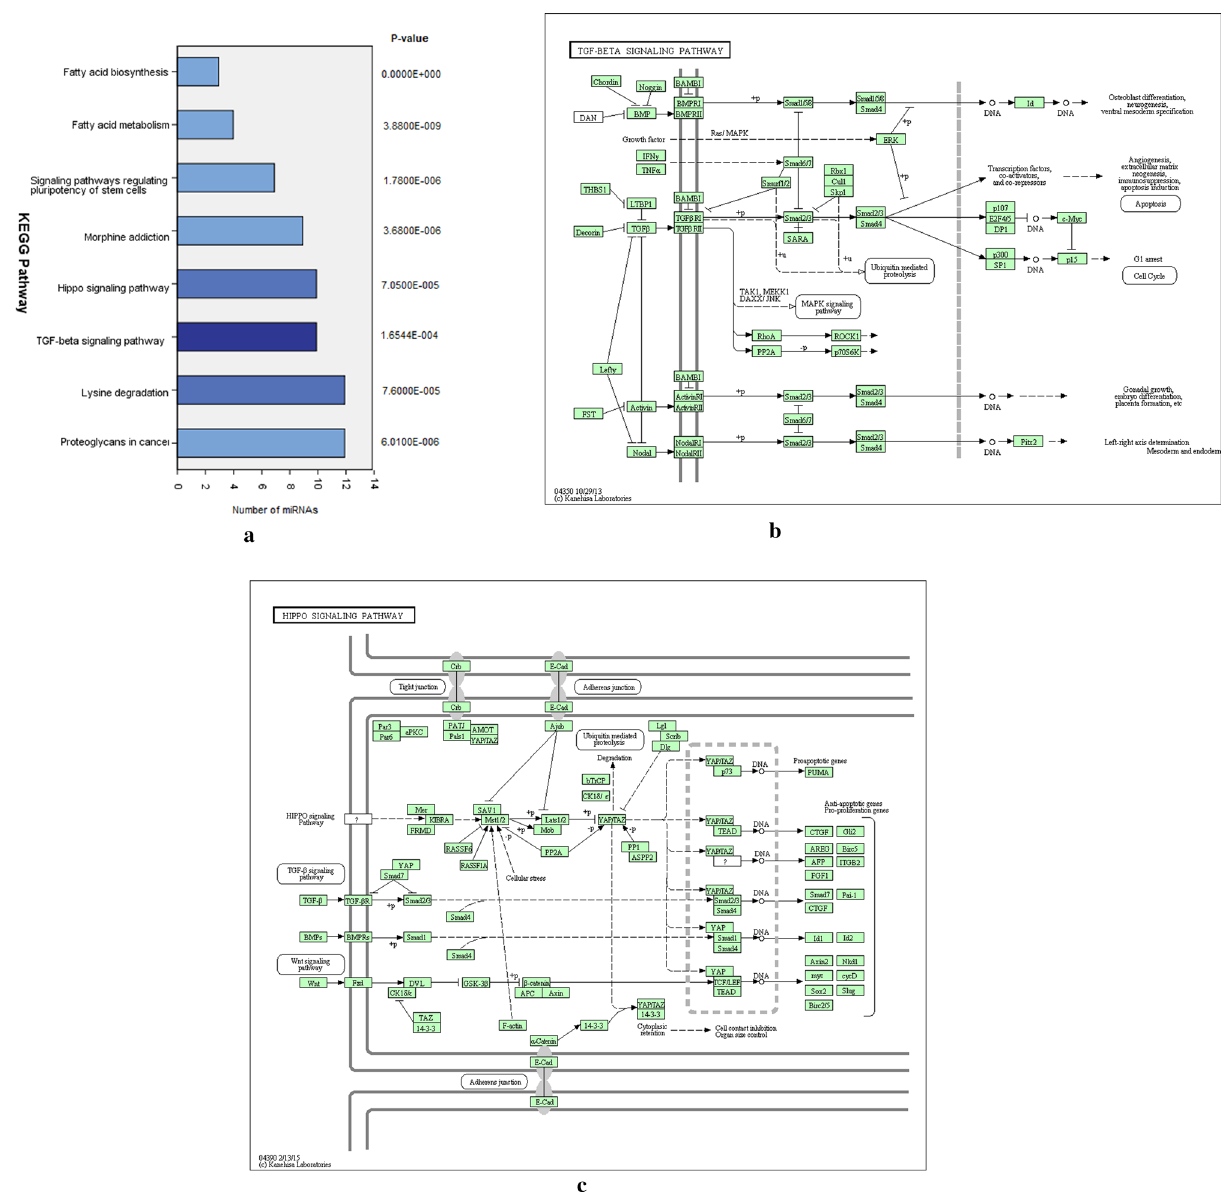
Figure 6. ( a ) KEGG analysis summary. KEGG analysis summary of pathways affected in DicerKD hMSCs. ( b ) TGF-β signalling pathway components identified in the genome and transcriptome WT hMSCs assignment of KEGG orthology terms. microT-CDS predicted miRNAs involved in this pathway include hsa-miR-548w, hsa-miR-6833-3p, hsa-miR-4772-3p, hsa-miR-5683, hsa-miR-548ax, hsa-miR-5000-3p, hsa-miR-548az-5p, hsa- miR-513b-3p, hsa-miR-365b-5p, hsa-miR-708-5p. ( c ) HIPPO signalling pathway components identified in the genome and transcriptome WT hMSCs assignment of KEGG orthology terms. microT-CDS predicted miRNAs involved in this pathway include hsa-miR-3914, hsa-miR-548w, hsa-miR-6833-3p, hsa-miR-5683, hsa-miR- 548ax, hsa-miR-5189-5p, hsa-miR-548az-5p, hsa-miR-708-5p, hsa-miR-4738-3p,